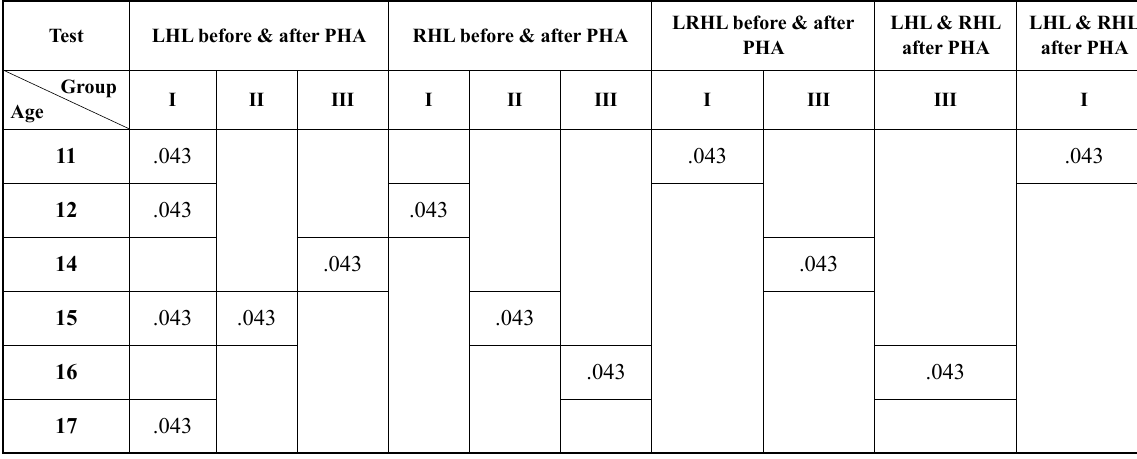
Table 2. Statistical significance between groups of subjects with different intellectual disability